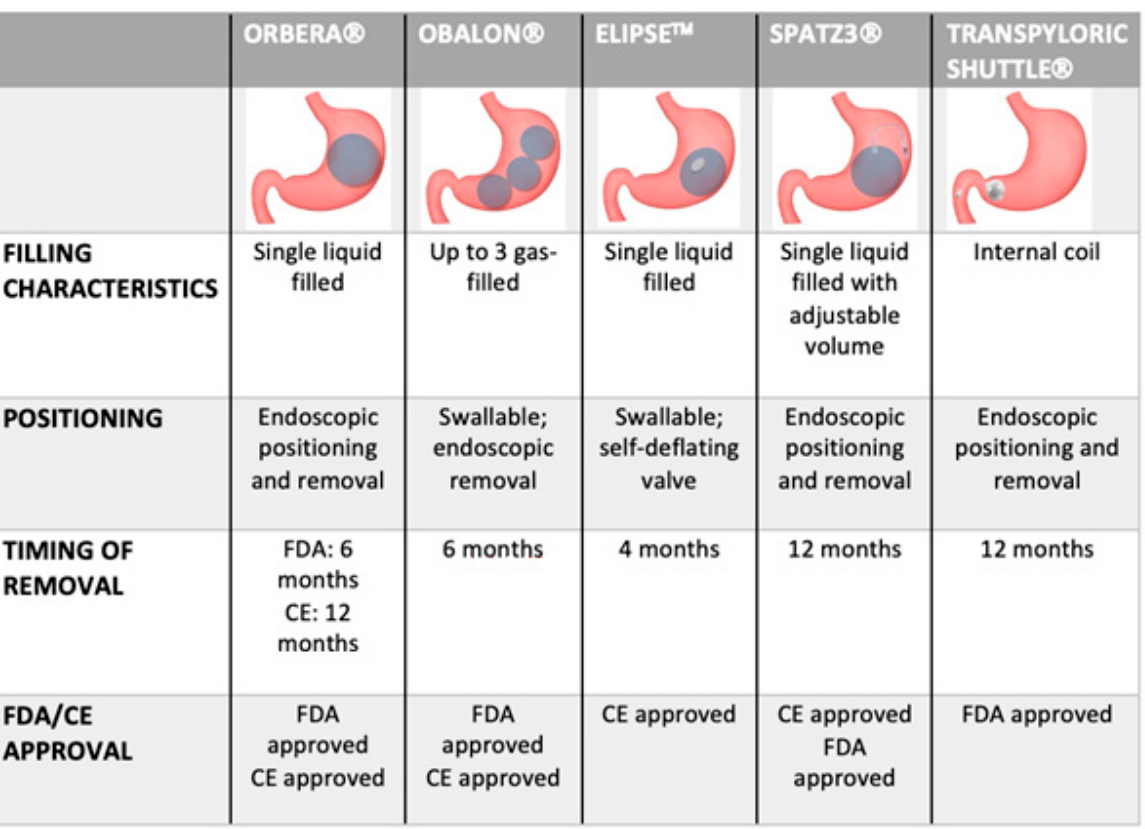
Figure 1. Schematic representation and characteristics of commercially available space-occupying devices. They are usually inflated with a fluid (saline solution, together with methylene blue) or, less frequently, with a gas, to a volume of 500–700 mL. Larger volumes lead to greater total body weight loss (TBWL), but smaller volumes are better tolerated by the